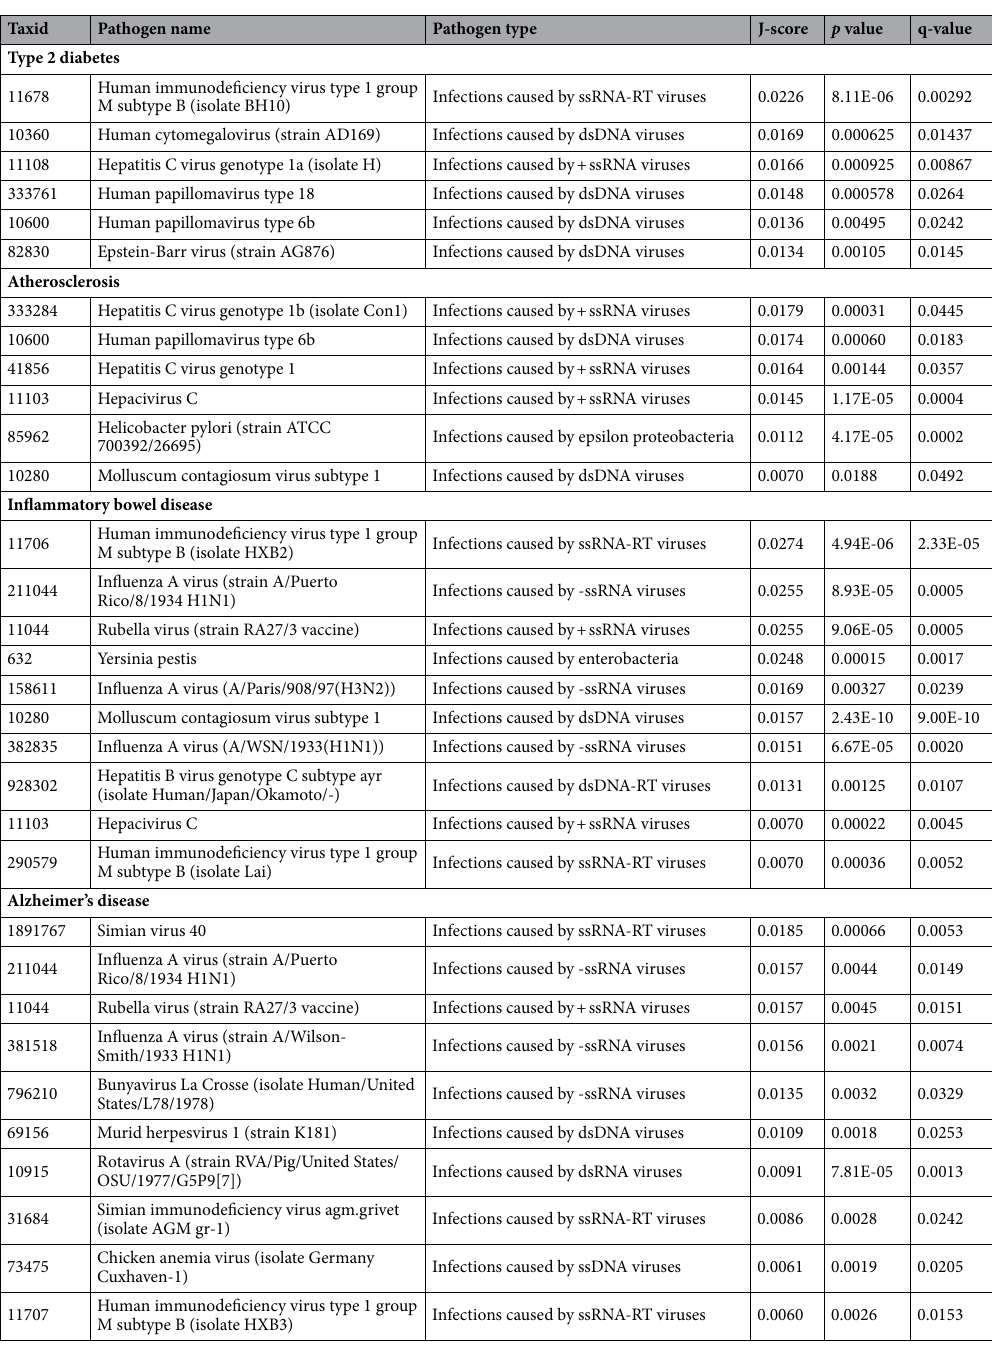
Table 3. Top 10 pathogens associated with 4 common complex diseases: Type 2 diabetes, Atherosclerosis, Inflammatory bowel disease, and Alzheimer’s